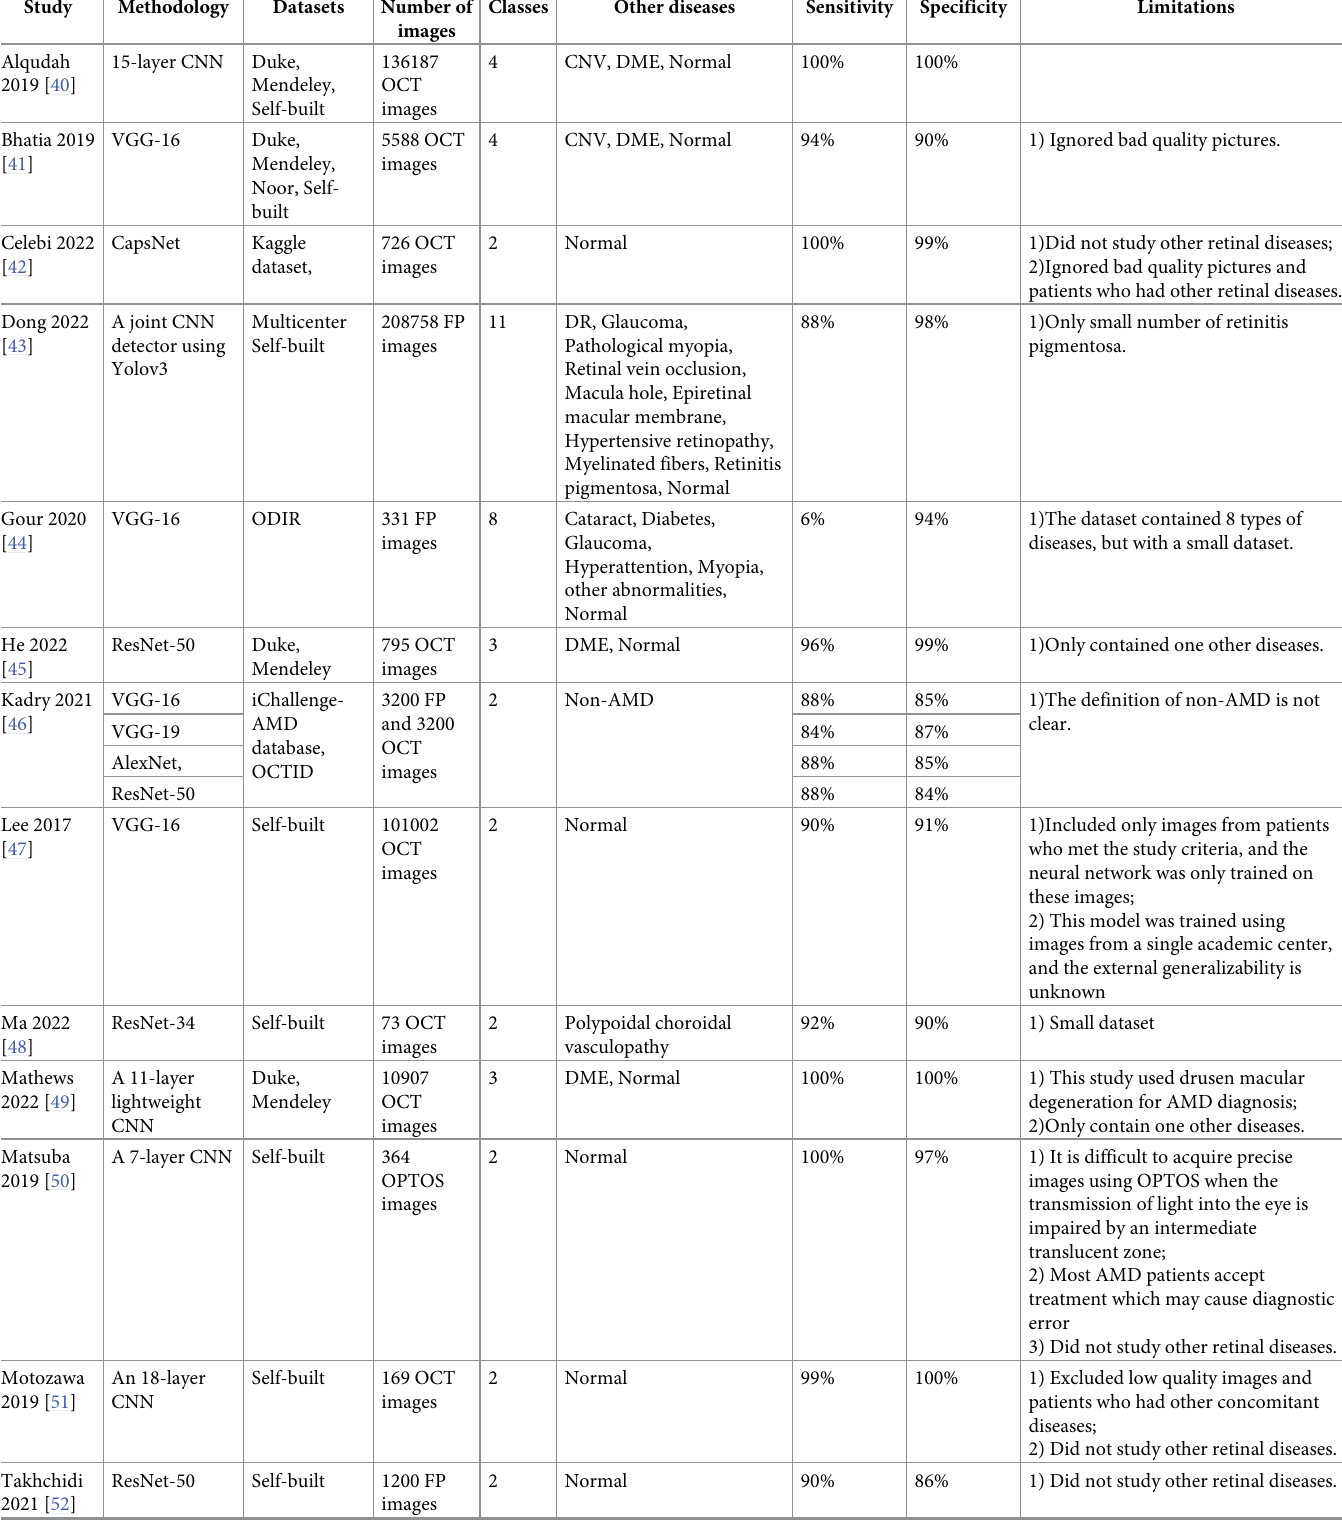
Table 2. Summary of each included